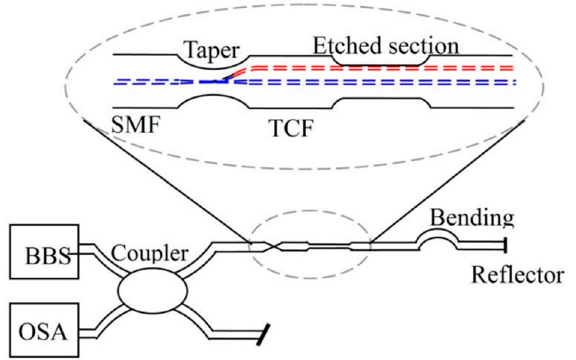
Figure 12. Experimental setup for the etched asymmetrical dual-core fiber Michelson interferometer refractive index sensor [36].